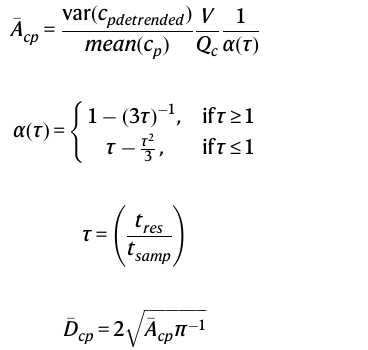
ffiffiffiffiffiffiffiffiffiffiffiffiffiffiffi (cid:1) A cp π (cid:2) 1